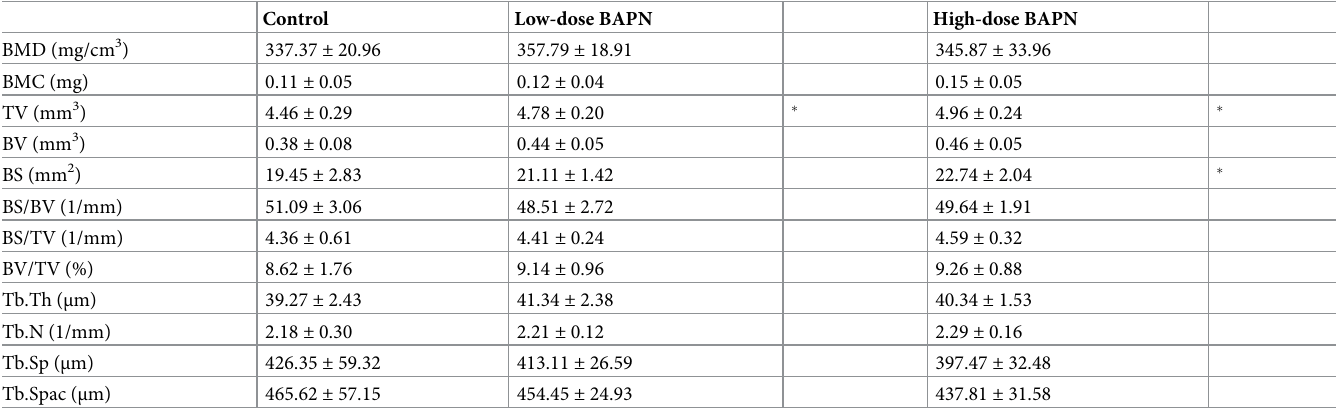
Table 1. Morphometric analysis of